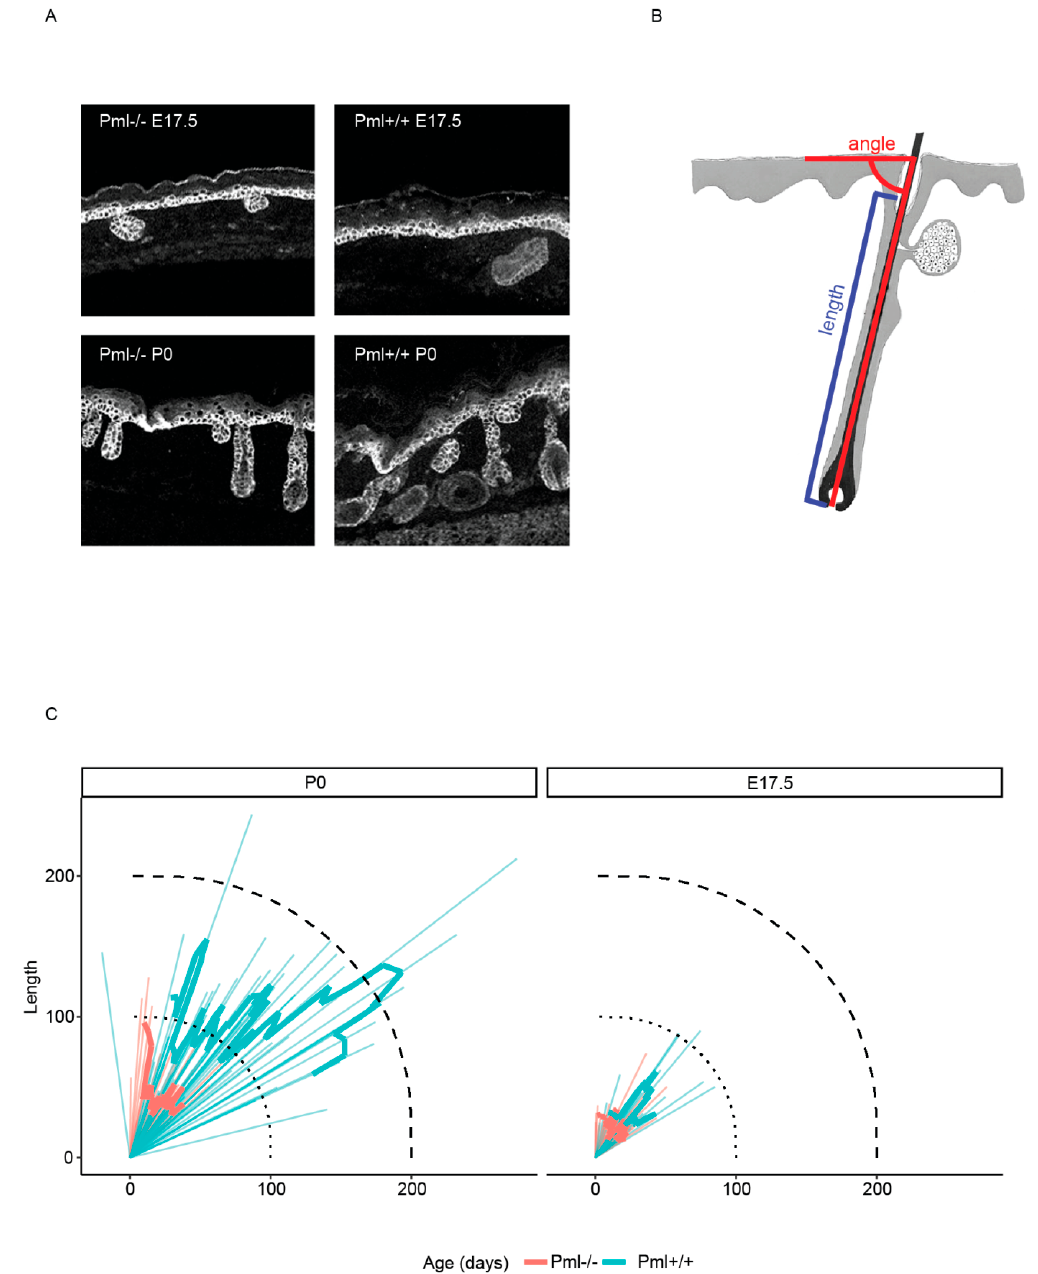
Figure 5. PML affects hair follicle size and orientation. ( A ) Representative sagittal images showing the morphology of hair follicles from PML-wt and PML-KO mice at stage E17.5 and P0. Samples have been IF labeled using antibodies against the basal keratinocyte marker K5 (red). ( B ) Schematic showing method for calculation of hair follicle size and orientation relative to the skin surface. ( C ) Polar diagram showing length and relative orientation of hair follicles from Pml +/+ and Pml − / − mice at the P17 and P0 developmental stages of mouse development.